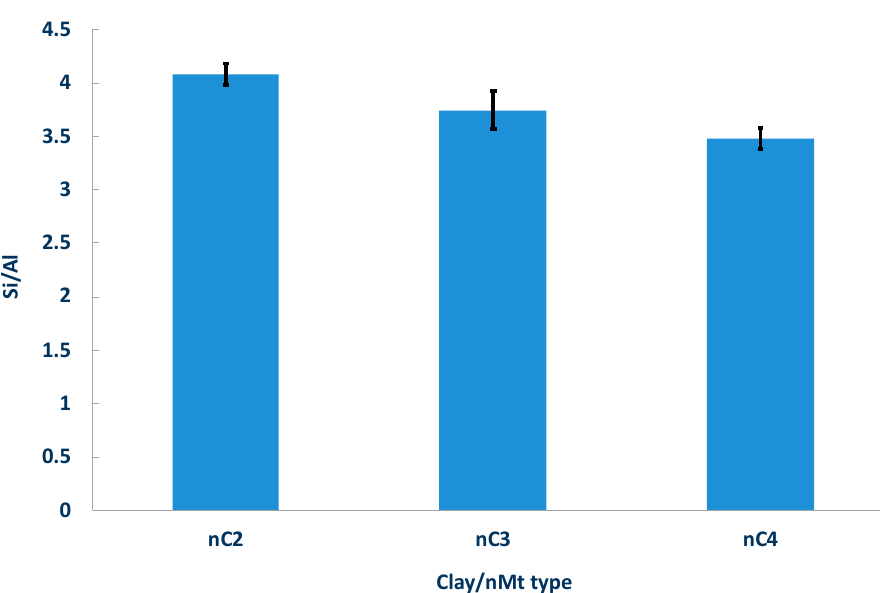
Figure 5. Comparison of the Si / Al ratios of the organomodified nanomontmorillonite (MMT) dispersion (nC2), the inorganic MMT dispersion (nC3) [19], and organomodified MMT powder (nC4). TG analyses of the organomodified MMT dispersion (nC2), inorganic MMT dispersion (nC3), and organomodified MMT powder (nC4).